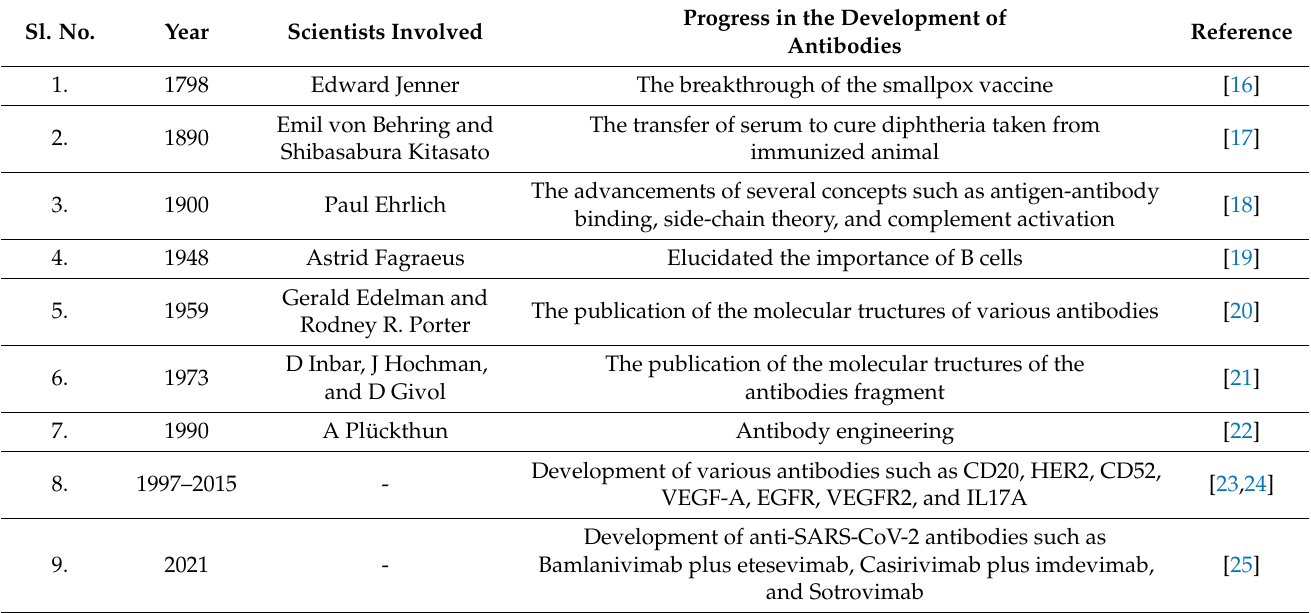
Figure 1. Timelines show different breakthroughs in antibody development. Table 1. Events that led to the development of antibodies.